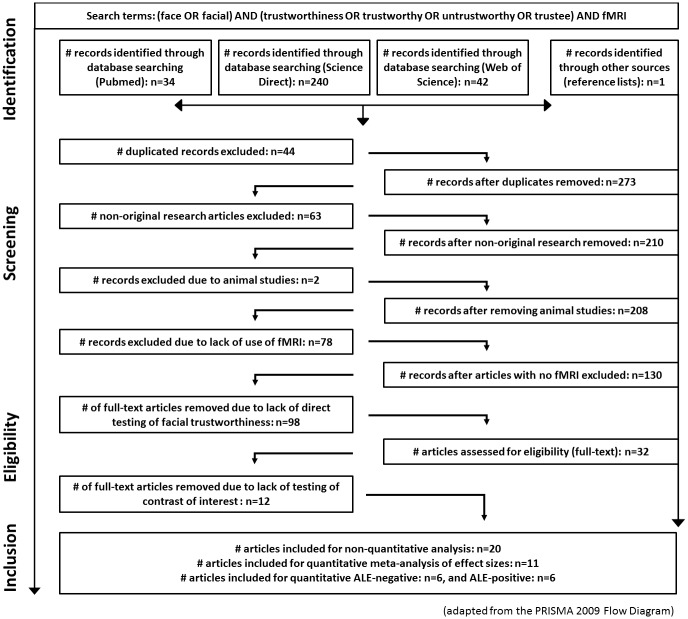
Flow diagram.Flow of information describing the different phases of the systematic review.